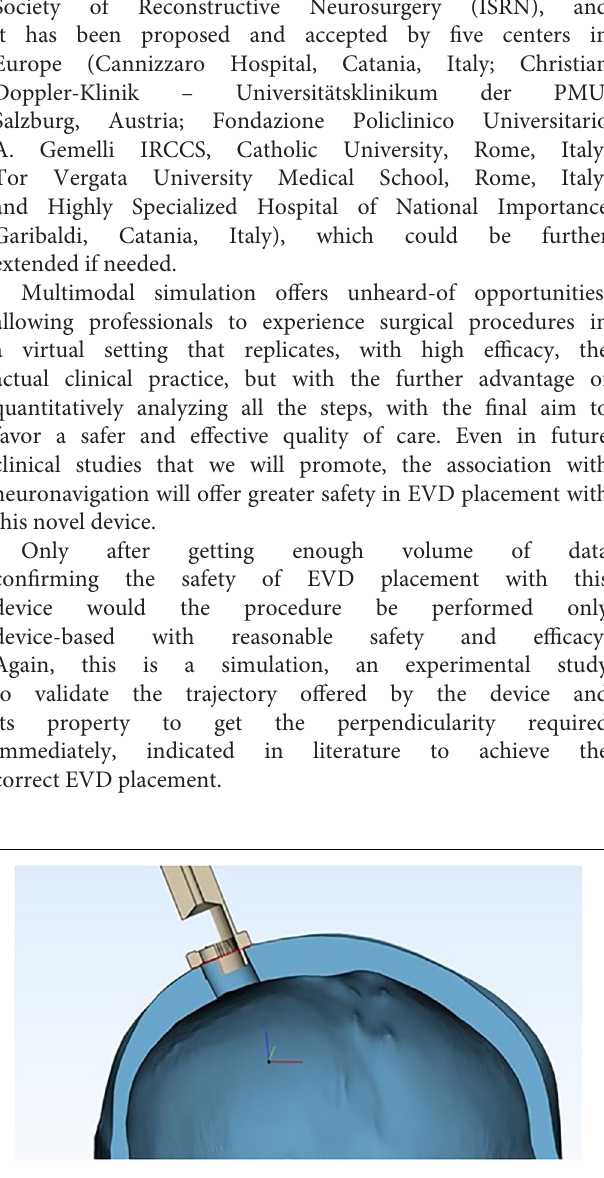
FIGURE 10 | Cross section of the device’s proximal end inside the burr hole, showing the skull’s geometric properties, assuming the skull as a sphere and the burr hole as a chord.